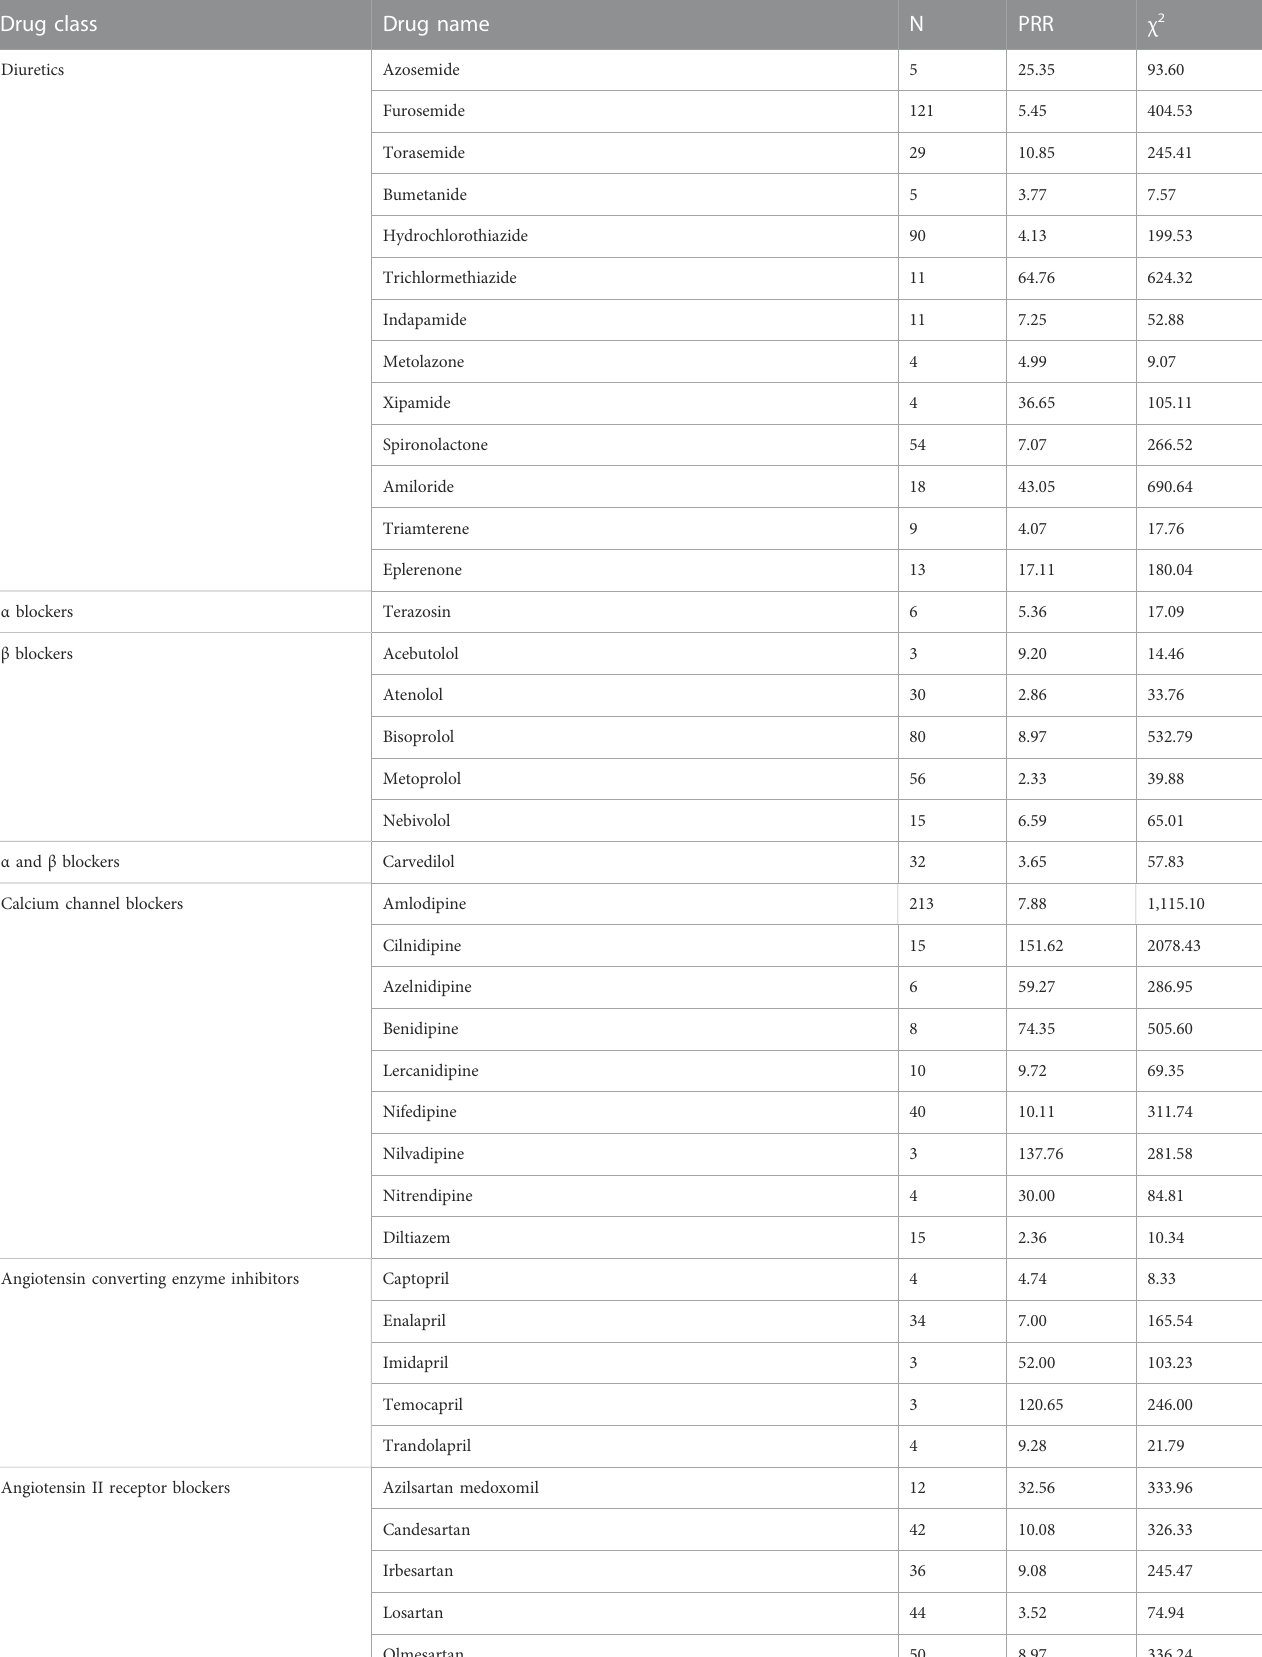
TABLE 2 Antihypertensive drugs with positive signals for